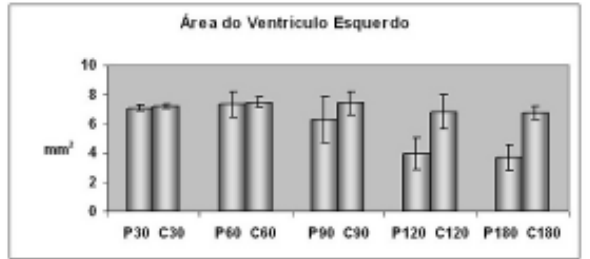
Fig. 6 – Área média da cavidade ventricular esquerda (em mm 2 ), nos grupos papaína e controle, nos diferentes períodos avaliados .